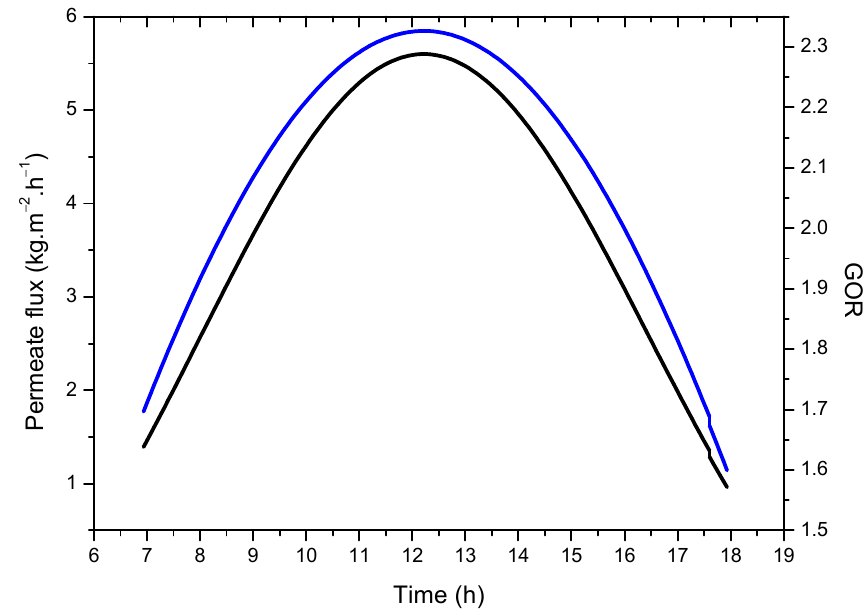
Figure 6. Variation of permeate flux and GOR over the local time.